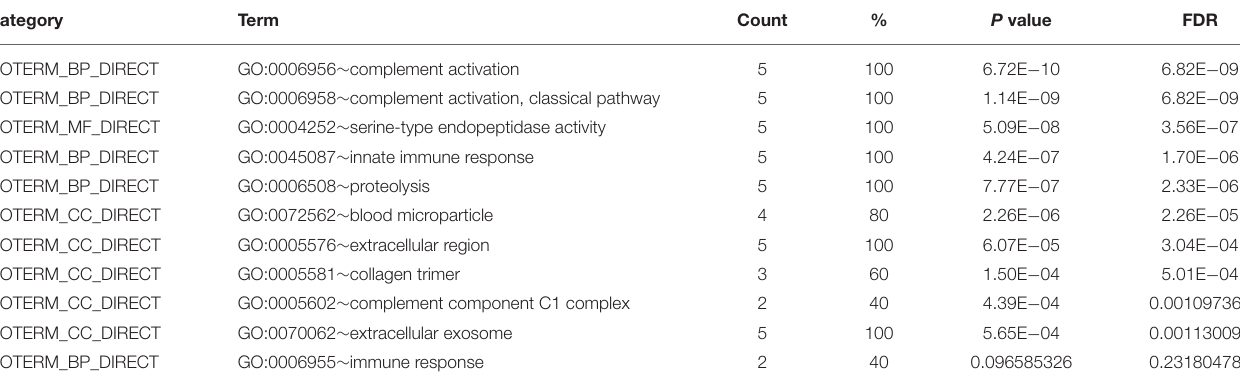
TABLE 1 | Enrichment analysis of GO pathway of module 1. Category